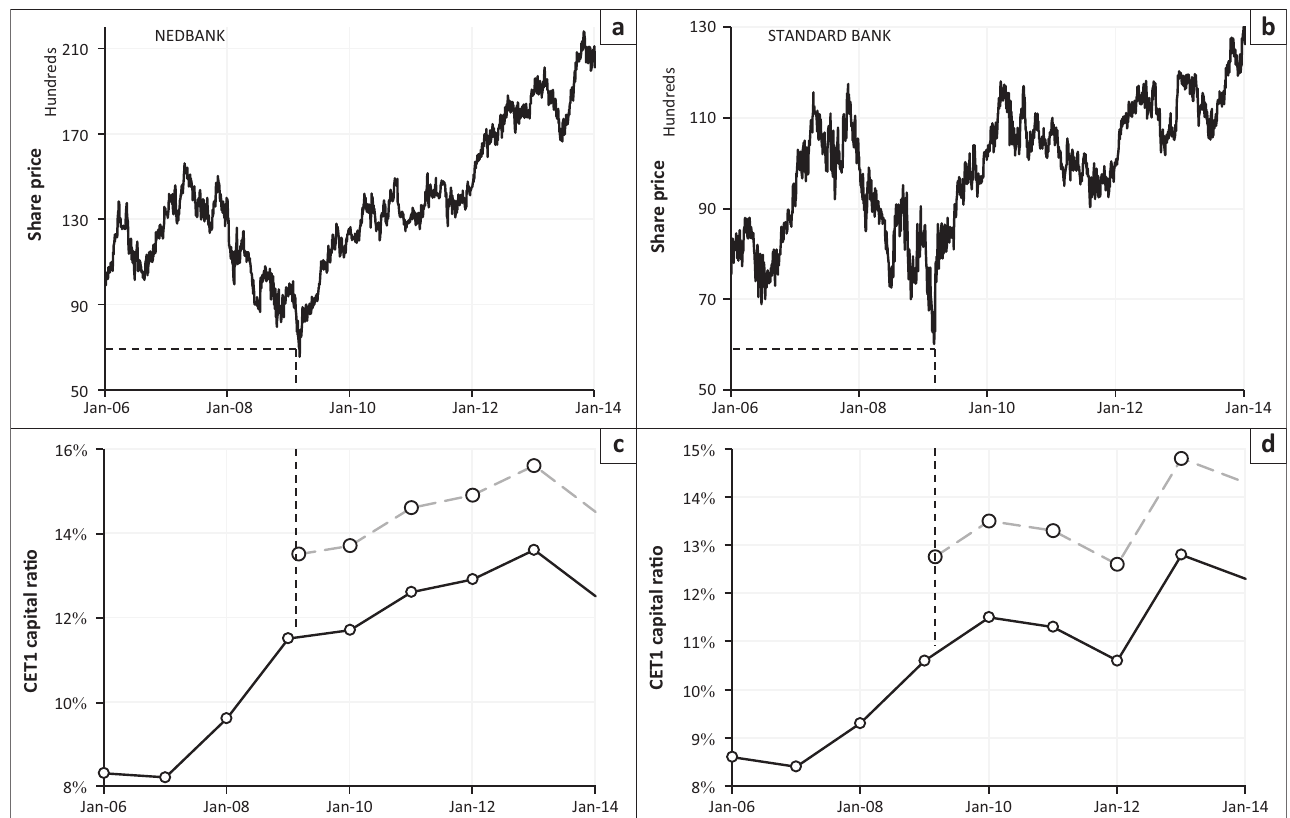
FIGURE 8: Share price of First National Bank (a) and Amalgamated Banks of South Africa (ABSA) (b) with common equity tier 1 capital ratios (c) prior to and(d) after contingent convertible conversions.